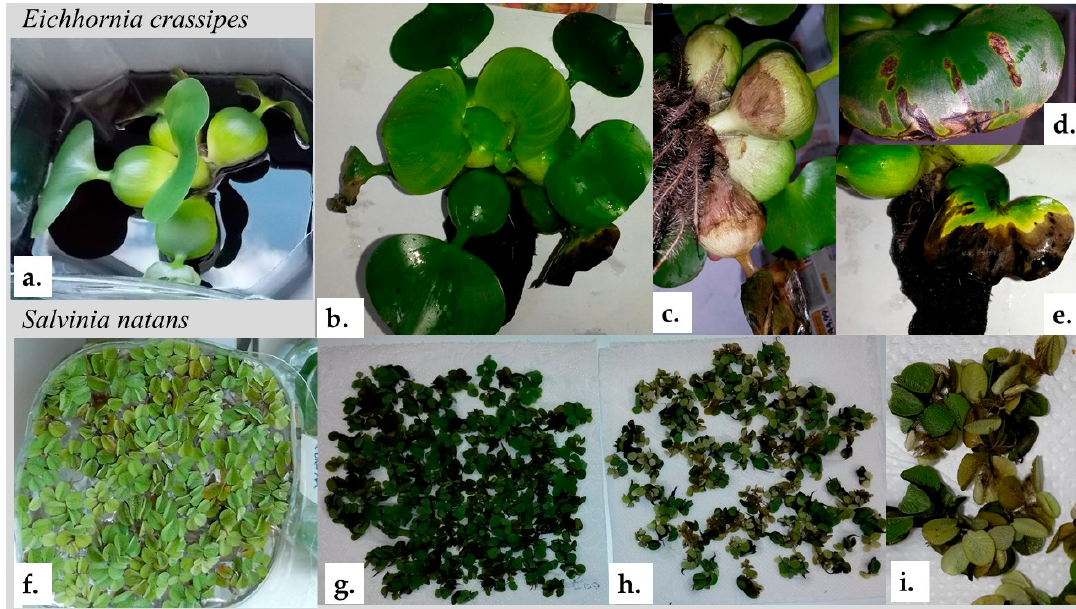
Figure 7. Photos of phytoremediation: ( a , f ) plants before remediation, ( b – e ) E. crassipes after adsorption, ( g ) control S. natans after remediation, ( h ) S. natans after remediation in 500 mg / L dye solution, ( i ) leaves of S. natans after remediation.